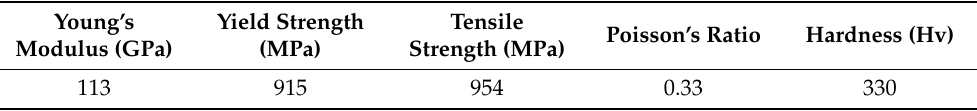
Figure 5. Microstructure of TC4 titanium alloy. Table 1. Material parameters of TC4 titanium alloy.